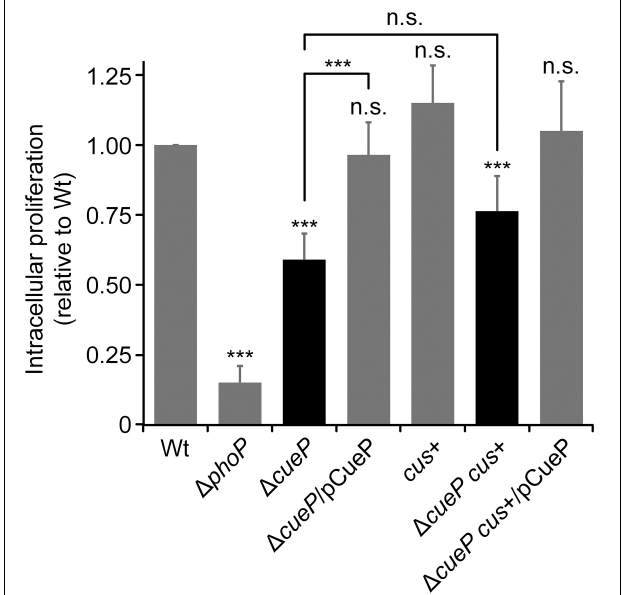
FIGURE 5 | Cus cannot substitute cueP for intramacrophage proliferation. Replication of wild type (WT), (cid:49) cueP , cus +, or (cid:49) cueP cus + Salmonella Typhimurium strains in RAW 264.7 macrophages at 18 h after infection. The virulence-defective (cid:49) phoP strain was included as control. Complementation of (cid:49) cueP or (cid:49) cueP cus + strains with pCueP is also shown. The values correspond to the average of at least three independent experiments carried out in duplicate, and the error bars represent SD. The asterisks denote statistical significance between means or with respect to WT. n.s., not significant; *** P <